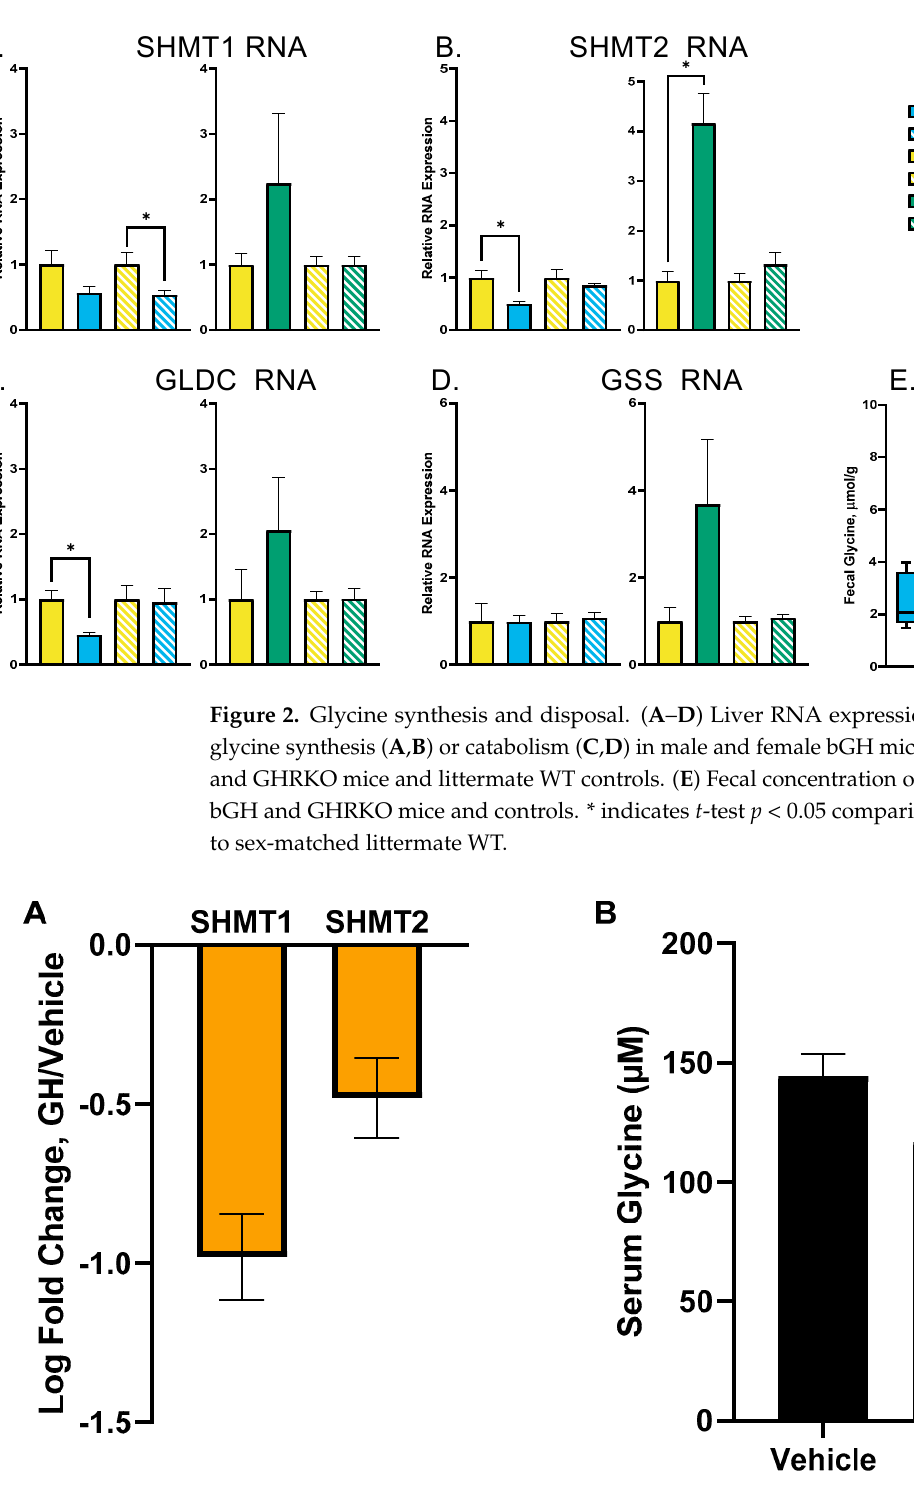
Figure 3. Acute effects of GH injection on glycine metabolism. ( A ) Liver RNA expression of glycine synthesis genes in male GH deficient (GHKO) mice injected with human GH or vehicle daily for five days. Data are expressed as the log2 fold change of GH-injected mice compared to vehicle-injected mice. ( B ) Serum glycine levels of the GH or vehicle-injected mice measured with a fluorometric assay. * Indicates t -test p < 0.05.